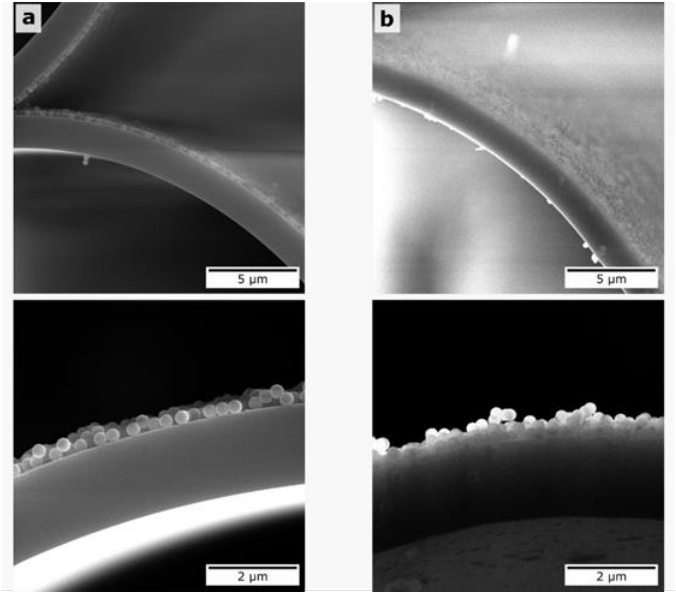
Figure 12. SEM images of MOW capillaries with two layers of 300-nm SiO 2 nanoparticles for the cases of ( a ) PDDA/PSS/PDDA and ( b ) PDDA intermediate layers, respectively.